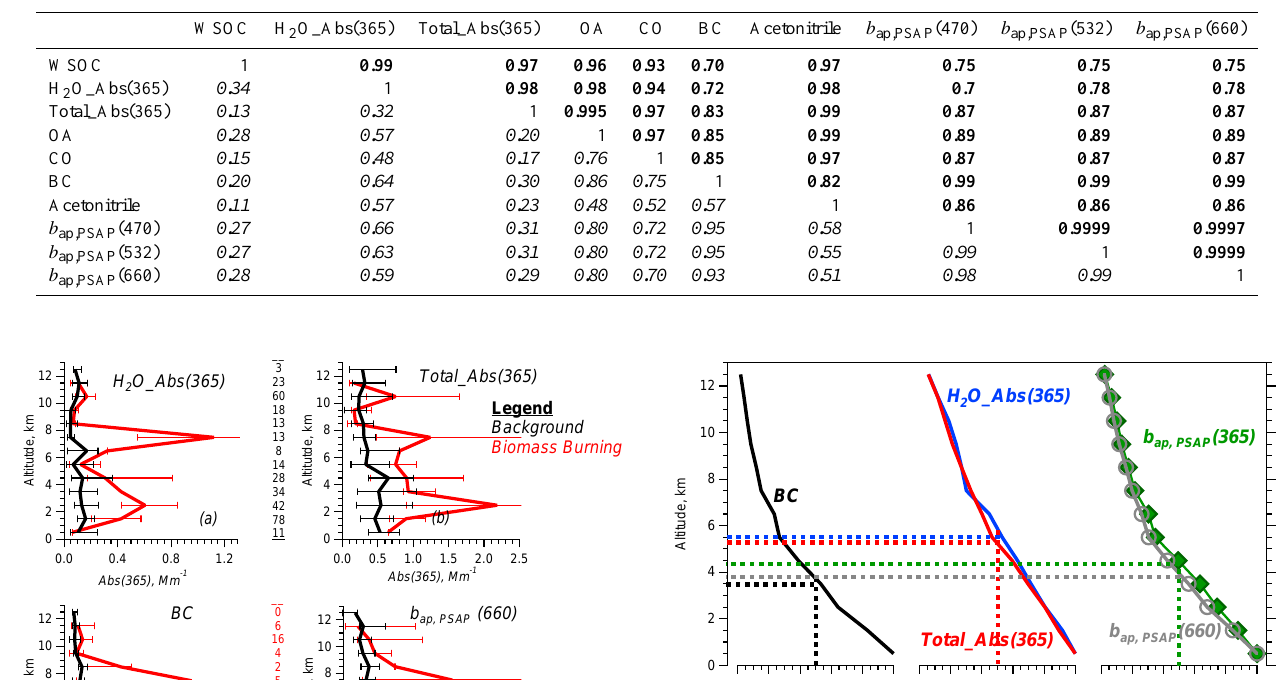
Table 4. Pearson rank correlations ( r ) for biomass-burning plumes and background conditions. Bold values above the matrix diagonal are from biomass-burning plumes (69 data points), while italic numbers below the matrix diagonal are from background conditions (334 data points). All data were averaged to filter sampling times.